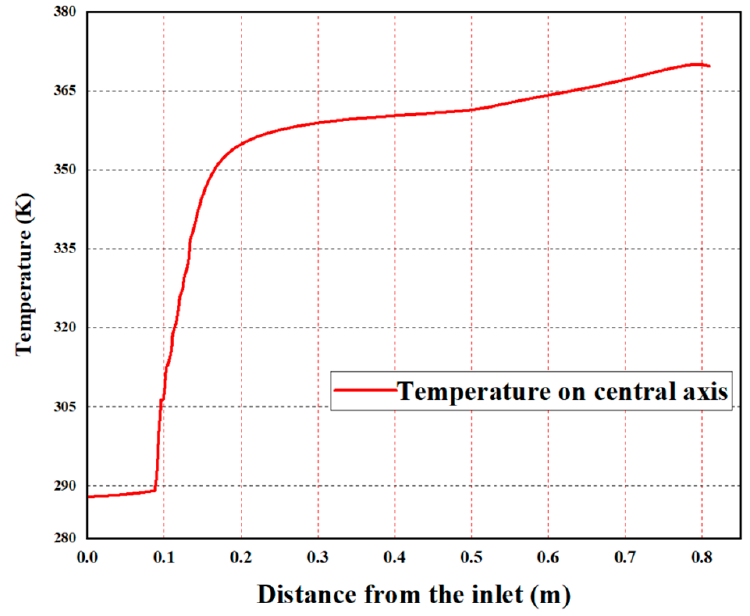
Figure 7. Temperature on the central axis of the cylinder at the end of fi lling.